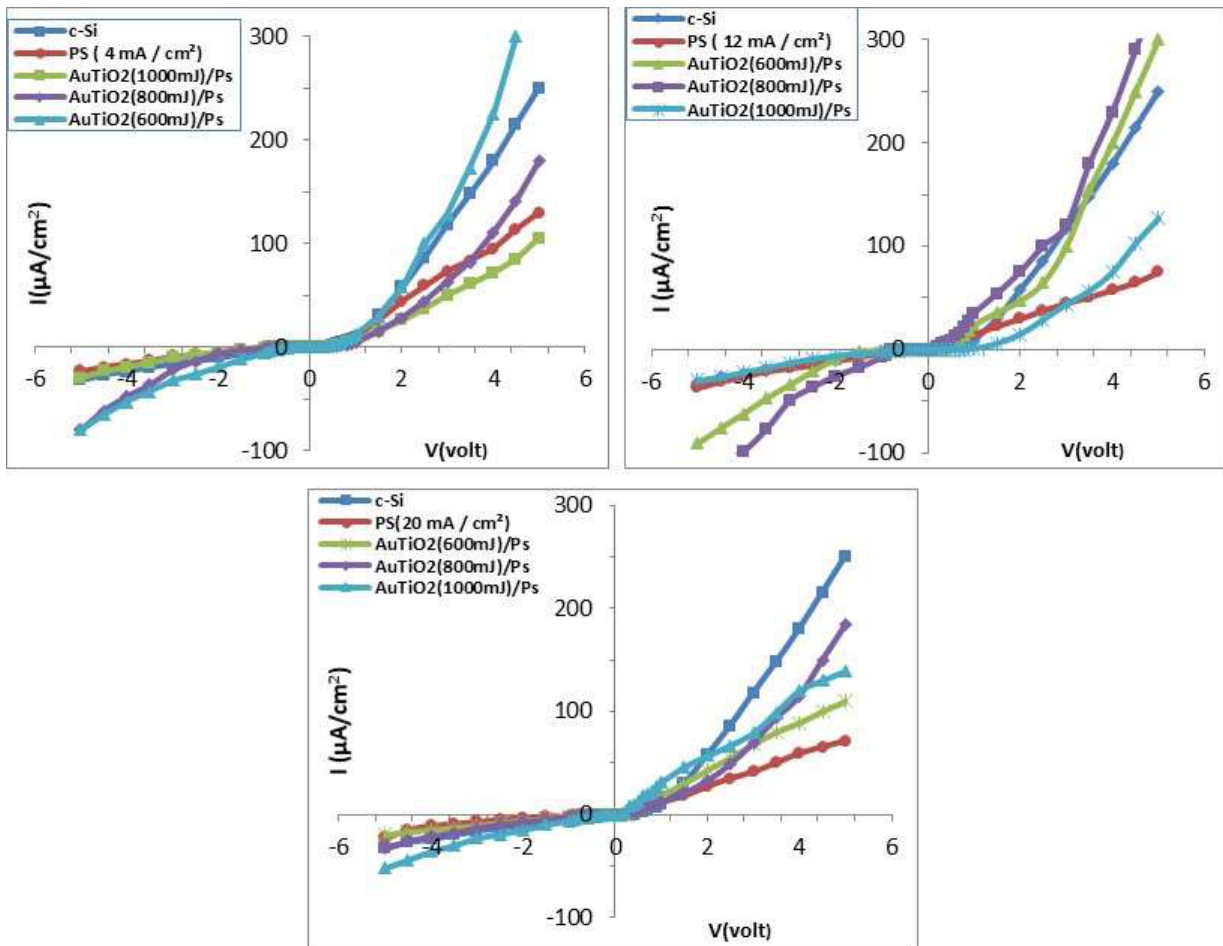
Figure 4: The I–V properties of PS and Al/Au: TiO 2 NPs/PS/n-Si/Al preparing at various laser energy and different current densities with fixed etching time (15 min) on the PS